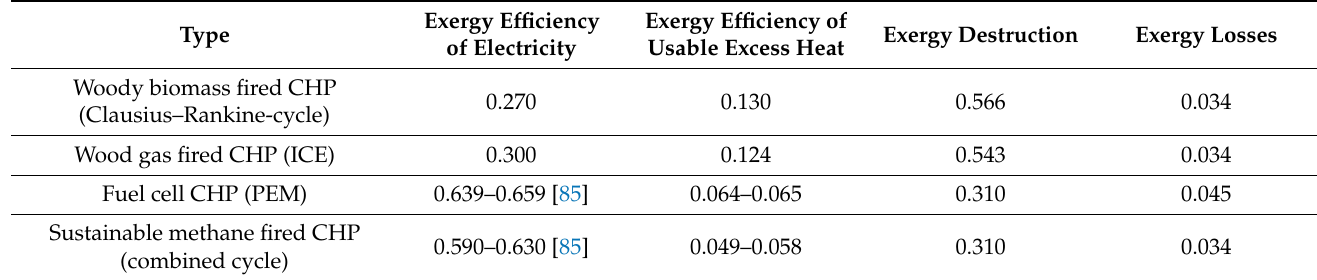
Table A2. Available CHPs of the scenario Energy Efficiency